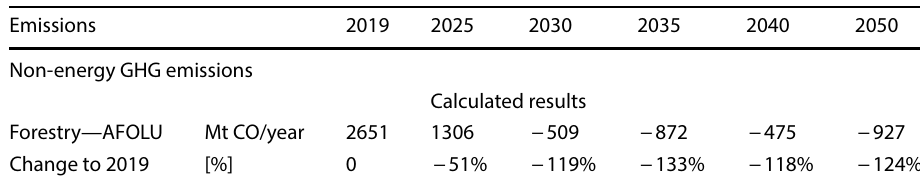
Table 11 Results: non-energy GHG emissions in the forestry